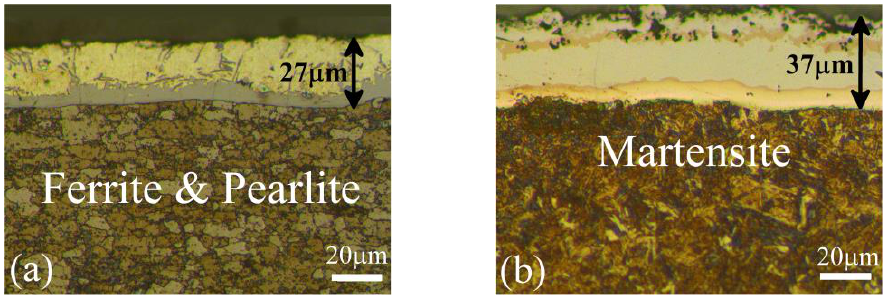
Figure 1. Microstructure of material and appearance of Al-Si coating: ( a ) as-received condition and ( b ) after heat treatment similar to the hot-stamped condition.